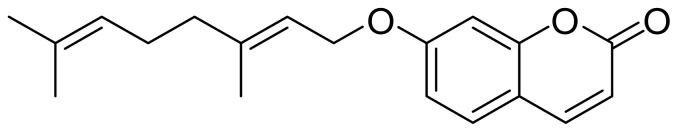
Chemical structure of auraptene (AUR).